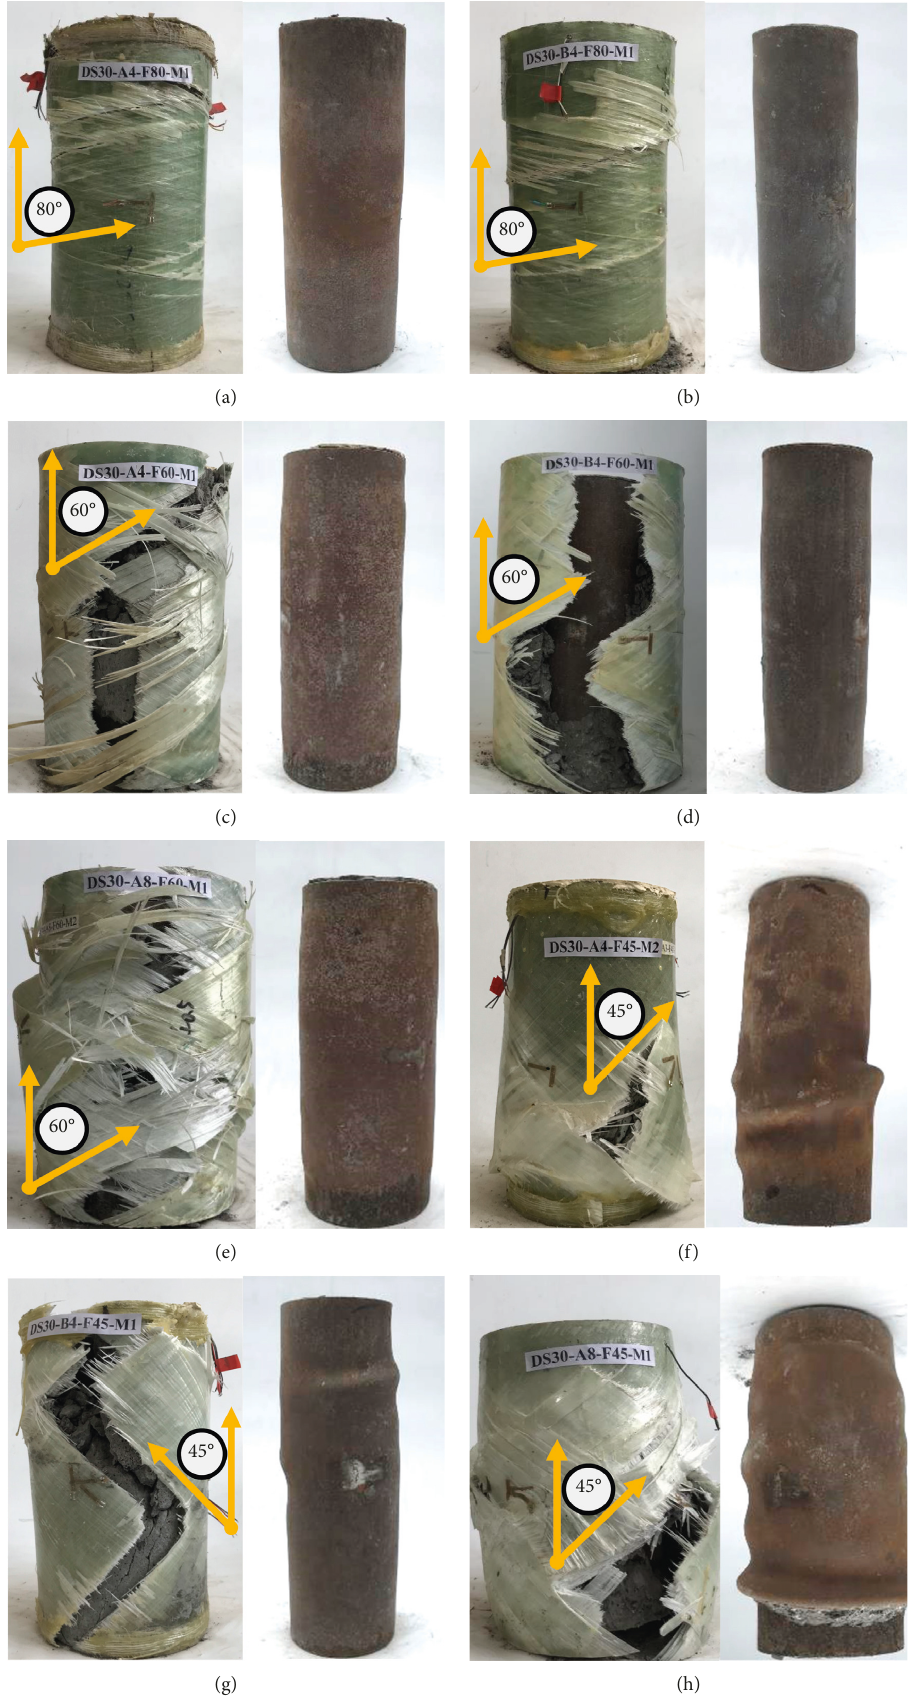
Figure 13: Typical DSTCs after test. (a) θ � ± 80 ° ; t � 4mm; Type A steel tube. (d) θ � ± 60 ° ; t t frp Type A steel tube. (g) θ � ± 45 ° ; t